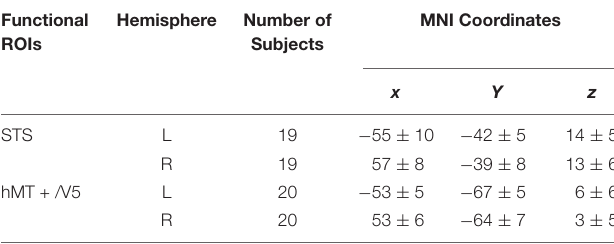
Number of subjects in whom the ROIs were localized and the average Montreal Neurological Institute (MNI) coordinates (mean ± standard deviation SD) are reported. STS, superior temporal